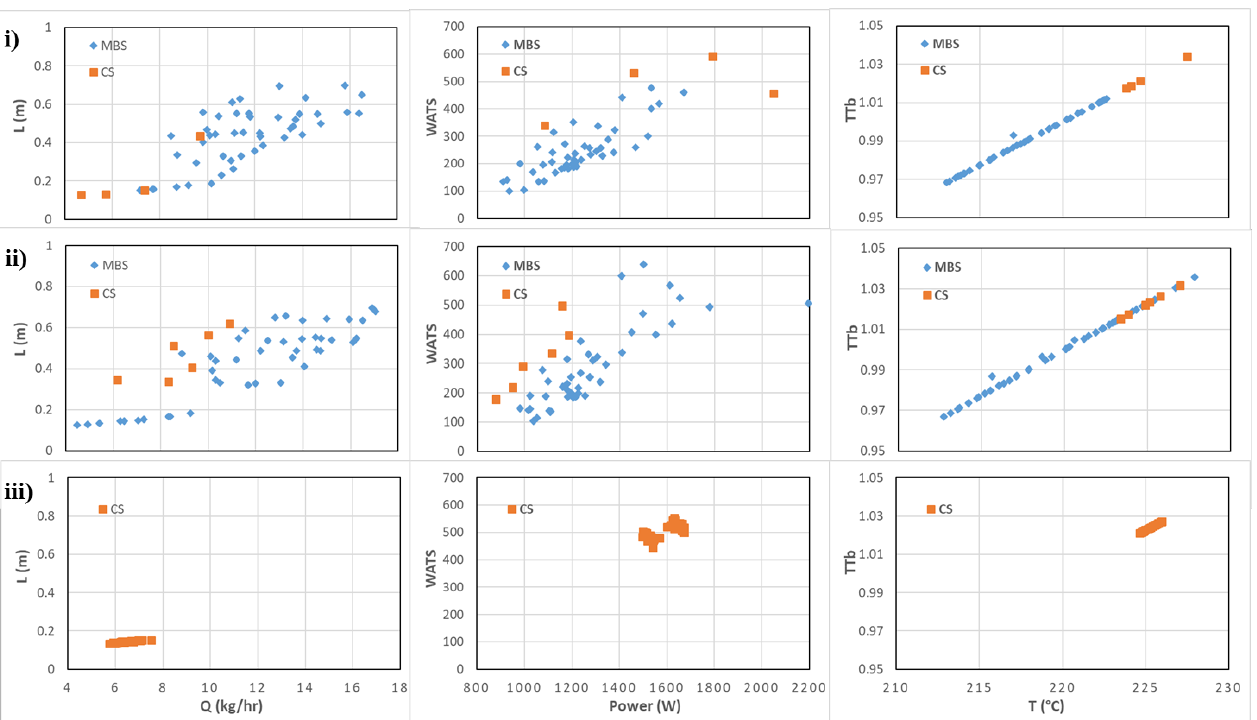
Figure 10. Pareto-optimal fronts after 100 generations for the pair of objectives identified in Figure 8 for Case 7. for Case